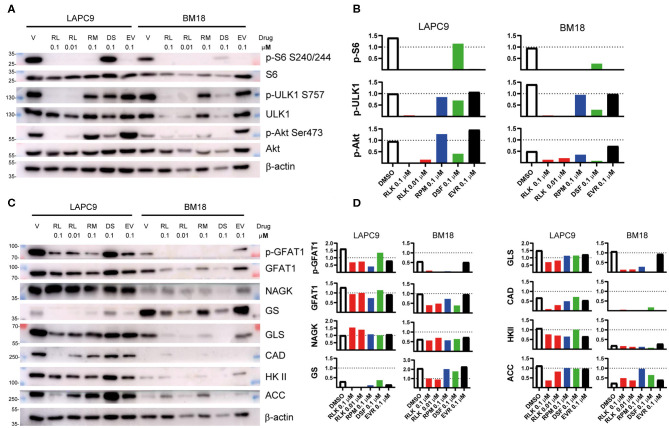
Total lysates of LAPC9 and BM18 organoids treated with rapalink-1 (RL, red bars), rapamycin (RM, blue bars), everolimus (EV, black bars), disulfiram (DS, green bars), or vehicle (V, DMSO, open bars), at the reported concentrations (μM) for 48 h were fractionated by SDS-PAGE followed by Western blotting. Phosphorylated sites or total proteins were detected by immunoblotting using antibodies against the indicated phosphosites or protein. Molecular weight (MW) marker sizes are indicated on the left. Beta-actin was used as loading control. (A) The activation status of mTOR was assessed by analyzing the expression of the mTORC1 downstream targets ULK (p-ULK1, S757) and S6 (pS6, S240/244) and of the mTORC2 downstream target Akt (p-Akt, S473). (B) Quantification of the phosphosites analyzed in (A). (C) The lysates analyzed in (A) were further assayed for the activation of the hexosamine biosynthesis pathway (GFAT1; p-GFAT1, S243; NAGK) and of glutamine (GS, GLS), nucleotide (CAD), glucose (HK II), and lipid (ACC) metabolism. (D) Quantification of the targets assayed in (C). Glutamine:fructose 6-phosphate Amidotransferase, GFAT1; Glutamine synthetase, GS; Hexokinase II, HK II; acetyl-CoA carboxylase, ACC; Glutaminase, GLS; carbamoyl-phosphate synthetase 2, aspartate transcarbamylase, dihydroorotase, CAD; N-acetyl-Dglucosamine kinase, NAGK.